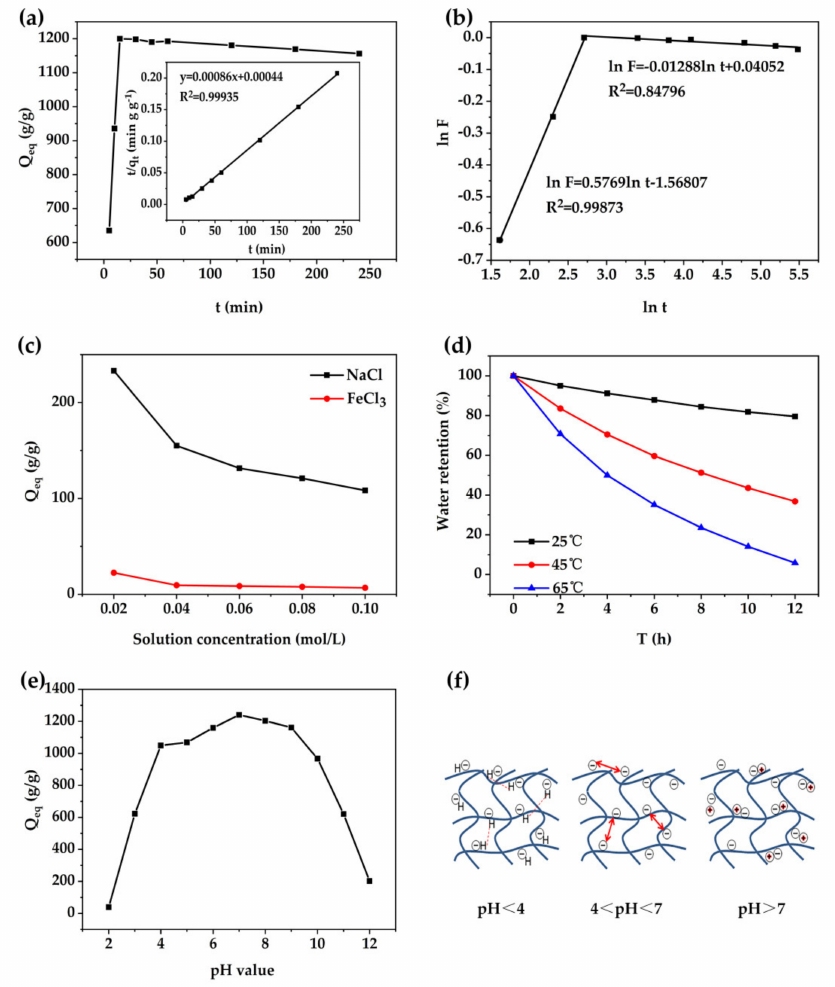
Figure 6. ( a , b ) Swelling kinetics of SAPC (4 wt. % KL), ( c ) Swelling capacity in different salt solutions, ( d ) Water retention at different temperatures, ( e ) The swelling capacity of SAPC (4 wt. % KL) in different pH solutions and ( f ) the swelling mechanism at various pH